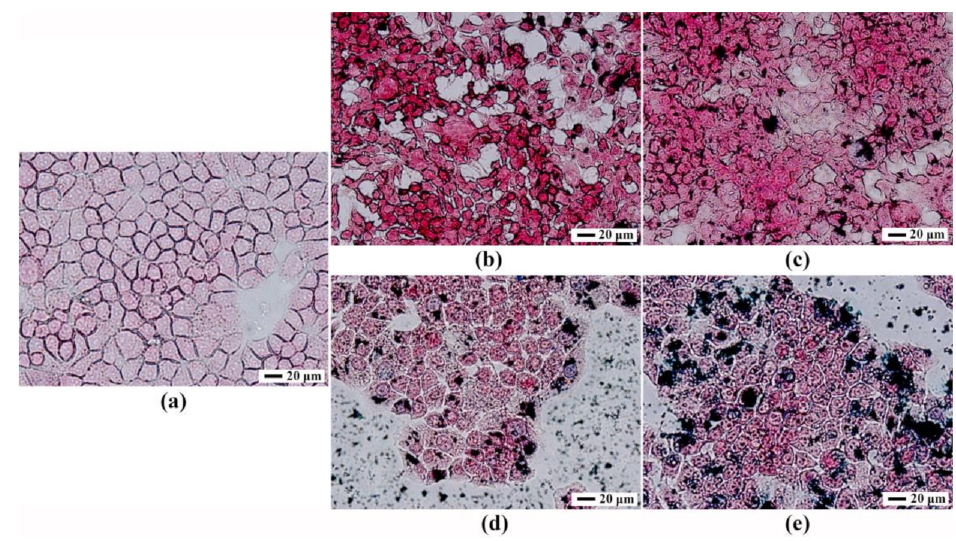
Figure 4. Prussian blue staining of human hepatocytes L-02 incubated by Fe 2 O 3 /Fe 3 O 4 heteroge- neous nanoparticles at 0 ( a ), 50 ( b ), 100 ( c ), 200 ( d ), and 400 ng/mL ( e ).